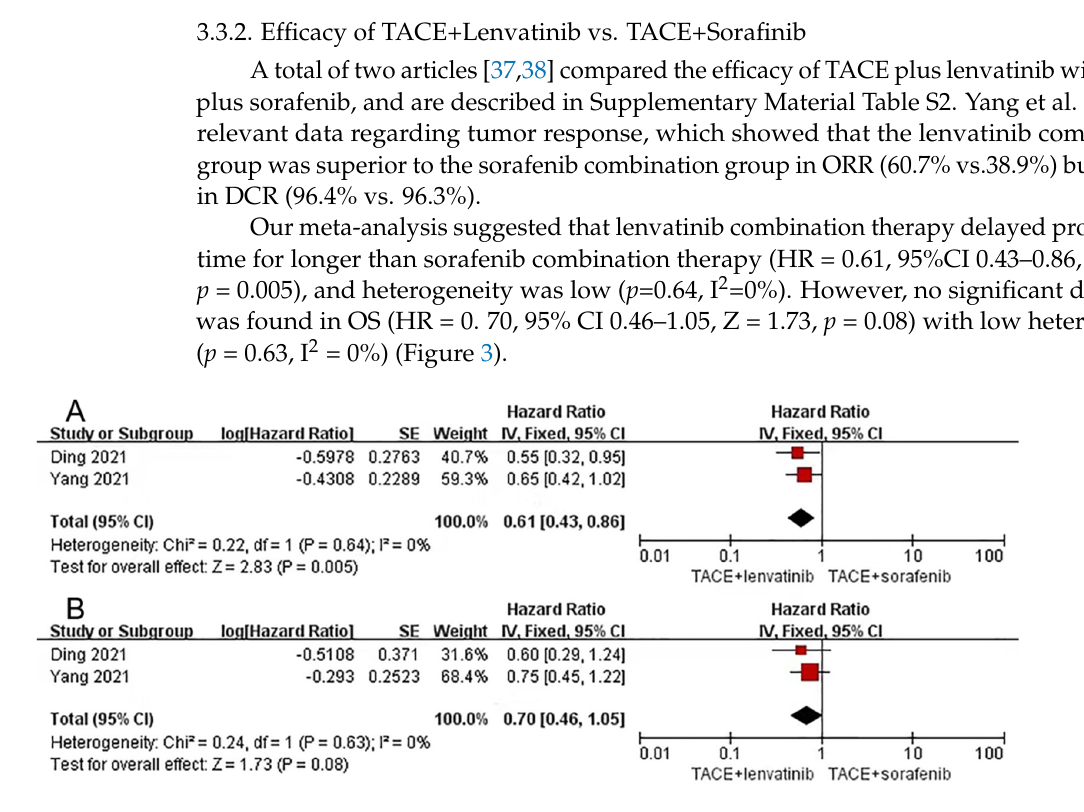
Figure 3. Forest plots for lenvatinib combination therapy vs. sorafenib combination therapy. Out- comes: ( A ): time to progression (TTP); ( B ): overall survival (OS). TACE: transarterial chemoemboliza- tion